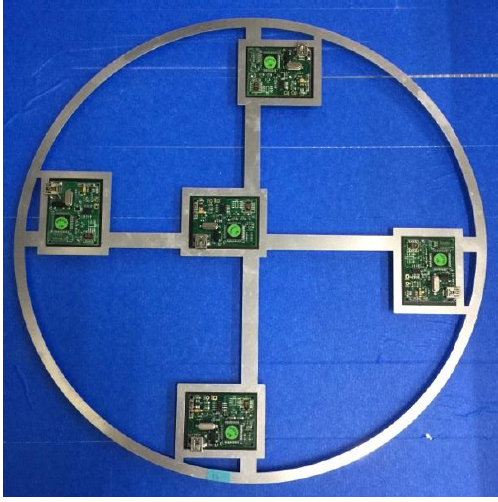
Figure 5. Dummy wafer embedded with five relative humidity (RH) sensors.